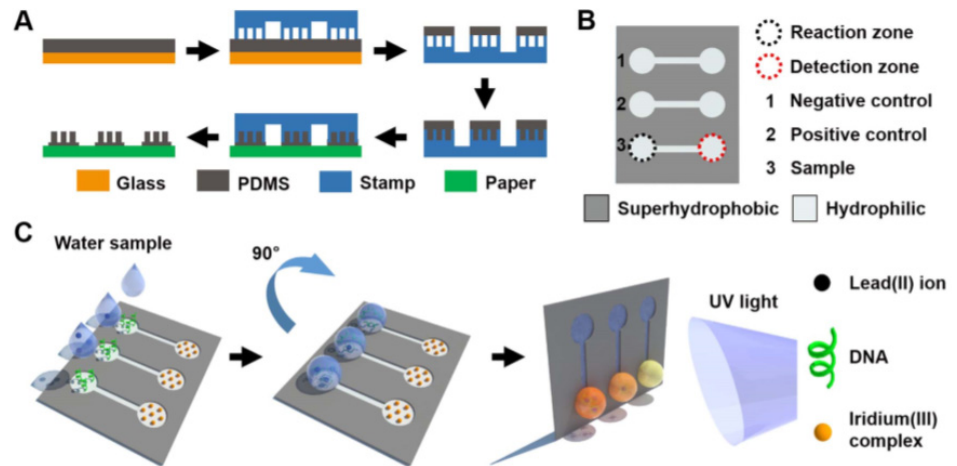
Figure 3. A diagram of the fabrication process of SD- μ PADs by Sun et al. [118]. ( A ) The manufacturing process of superhydrophobic coating on the paper substrate. A negative-relief Teflon stamp was placed onto a polydimethylsiloxane (PDMS)-coated glass slide and then removed to obtain a thin liquid PDMS coating. Following this, the stamp was pressed onto paper and heated at 90 °C for 15 min. Teflon stamp was peeled off, making a paper chip with superhydrophobic patterns. ( B ) The configuration of the paper-based chip. The zones and channels are hydrophilic, while the rest regions are superhydrophobic. ( C ) Diagram of lead (II) detection on the chip. The water samples were added to the reaction zone. After three minutes, the chip was turned by 90°, which enabled the droplet to travel to the detection zone and react with the iridium (III) complex. Figure reprinted with permission from Elsevier.